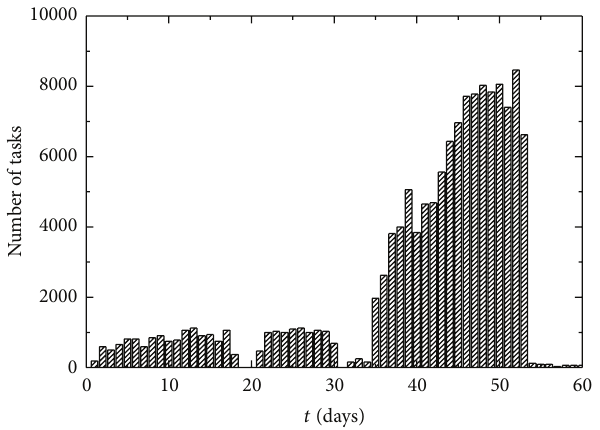
Figure 5: The probability for the emergence of a seasonal pattern in a network with 𝑁 nodes and the parameters for RSV propagation fitted to the Spanish region of Valencia data. Circles are simulation data; the continuous line is an exponential